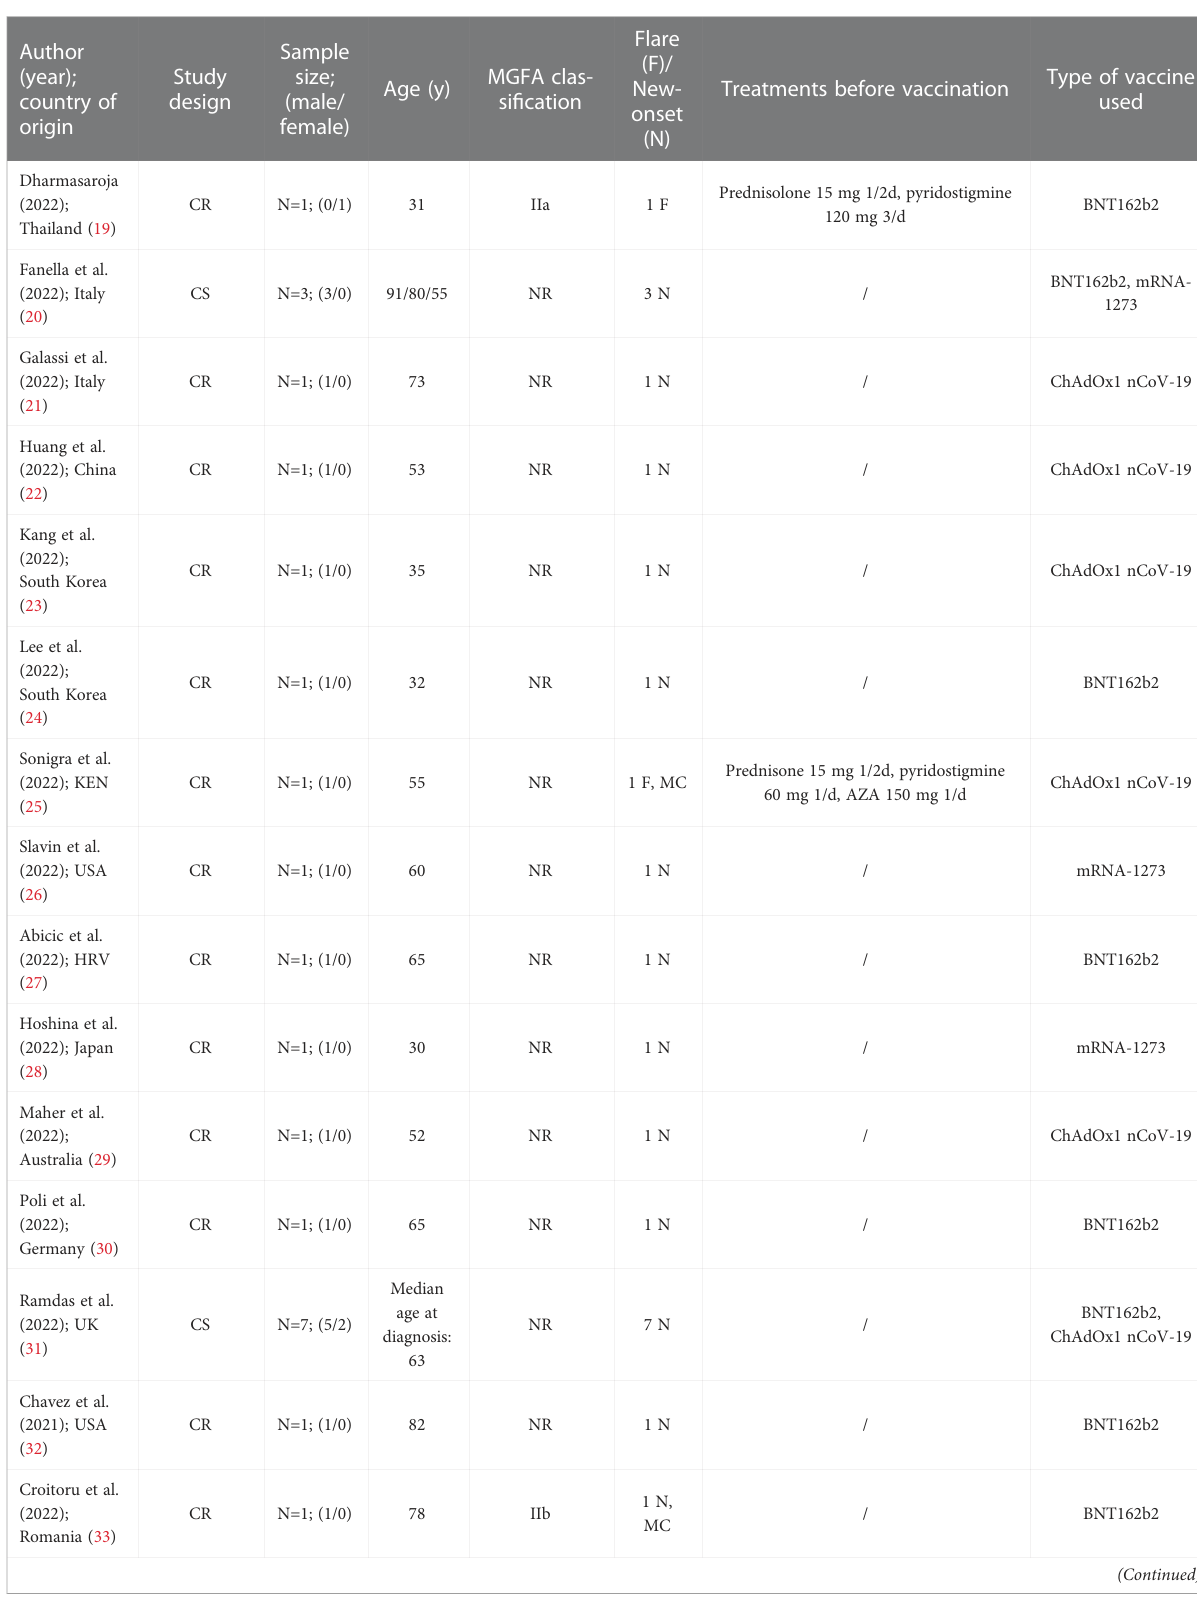
TABLE 2 Demographic and clinical characteristics of